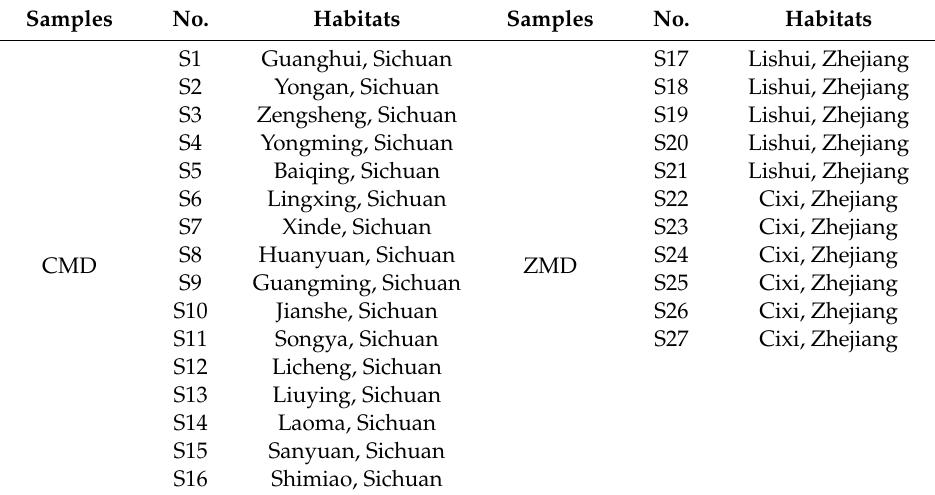
Table 3. Information of Chuan maidong (CMD) and Zhe maidong (ZMD).